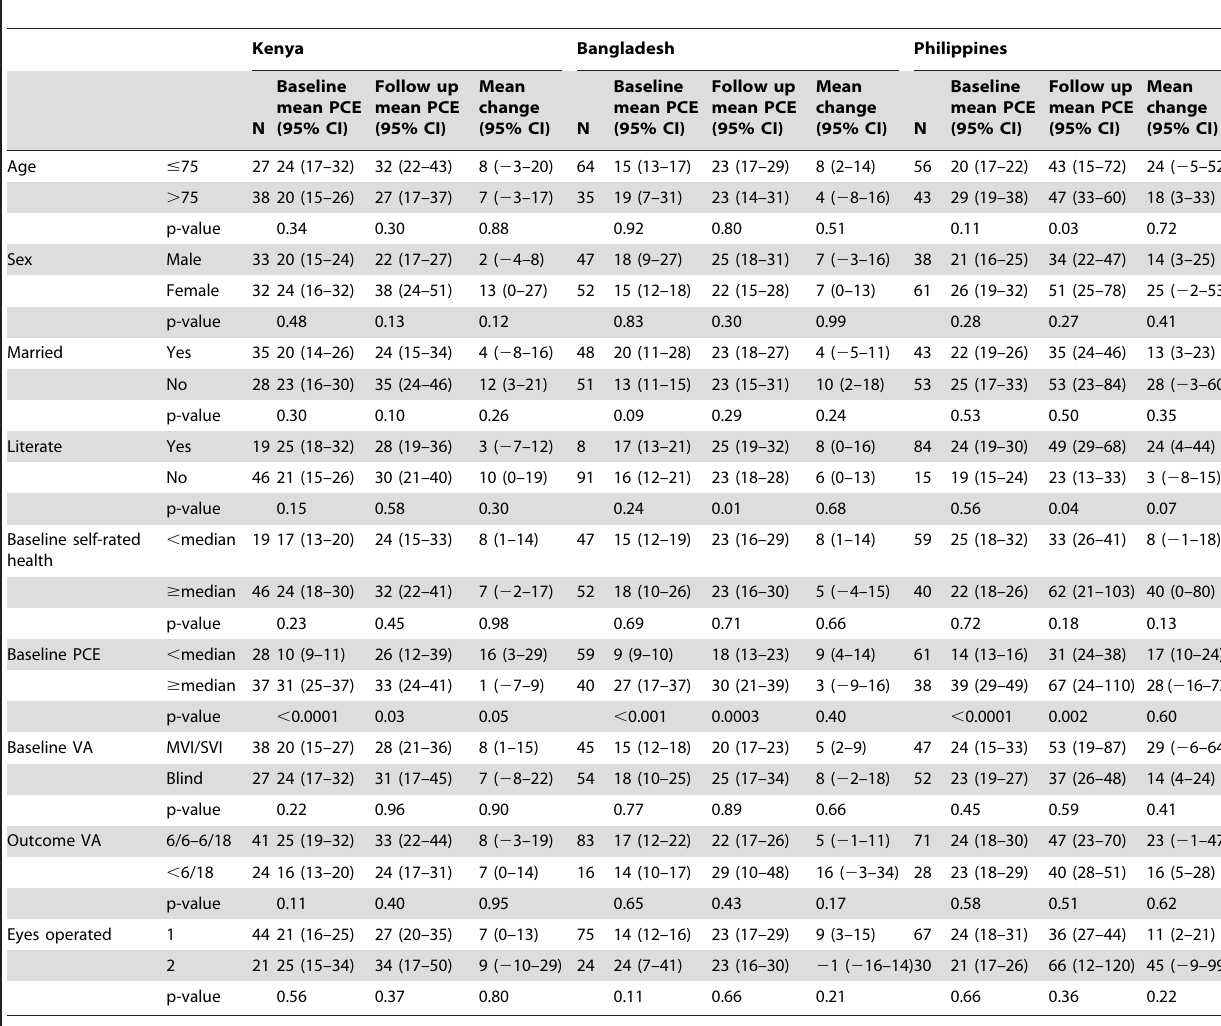
Table 6. Predictors of change in PCE between baseline and follow-up among operated